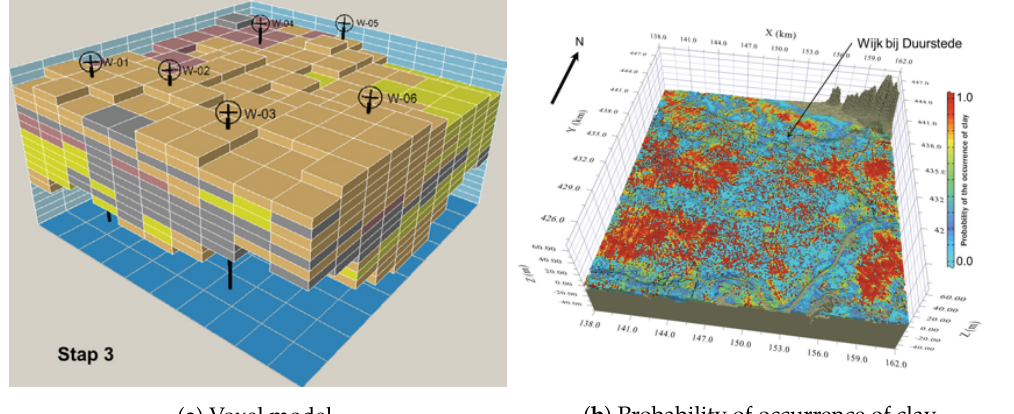
Figure 9. GeoTOP data is encoded based on a voxel model with a resolution of 100 × 100 × 0.5 m. Each voxel in the model contains information on the lithostratigraphy and lithological classes, including the probability of occurrence for each lithological class (the values are based on interpolations of data from